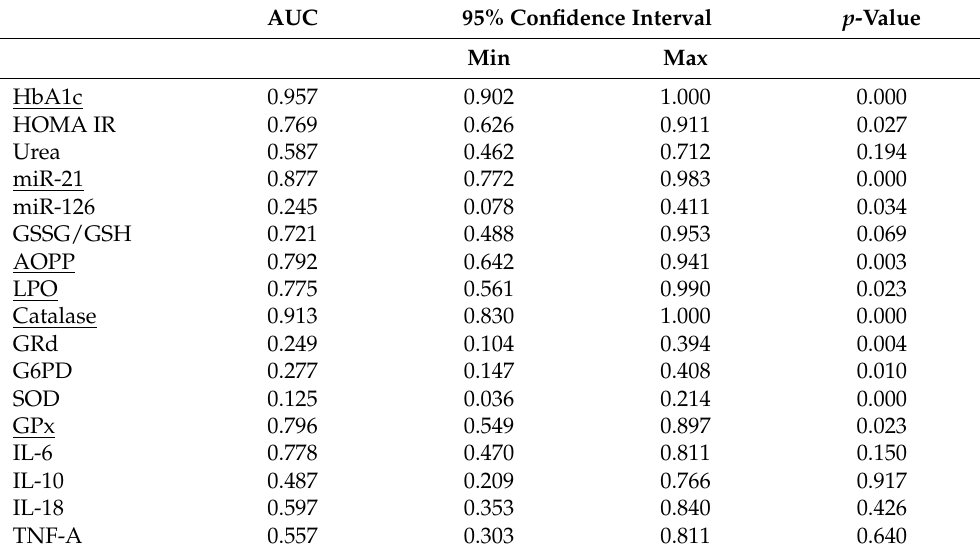
Table 5. AUC and 95% confidence intervals for studied markers distinguishing between control and T2DM groups.